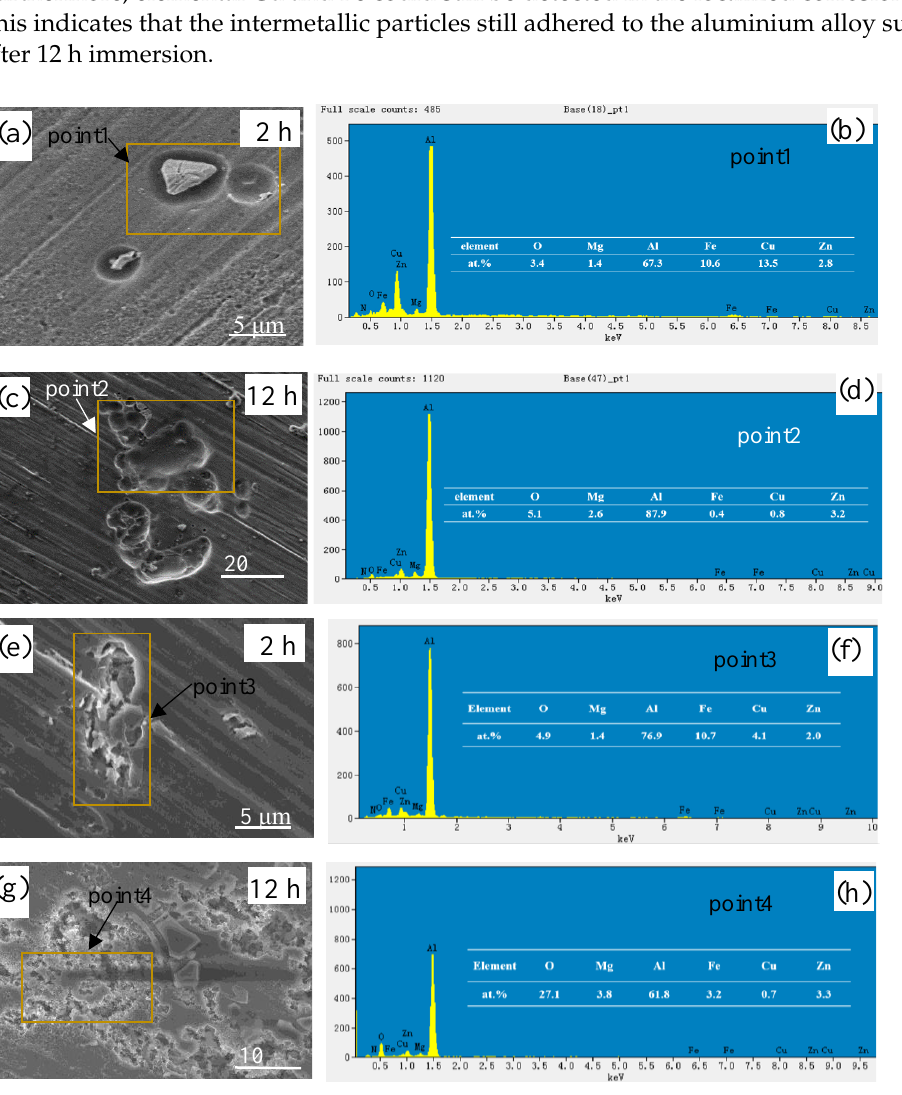
Figure 10. SEM and EDS of localized corrosion area inside the crevice in solutions without and with 0.5 wt.% NaNO 3 after corrosion fir 2 h and 12 h. ( a – d ) 0 wt.% NaNO 3 , ( e – h ) 0.5 wt.% NaNO 3 .